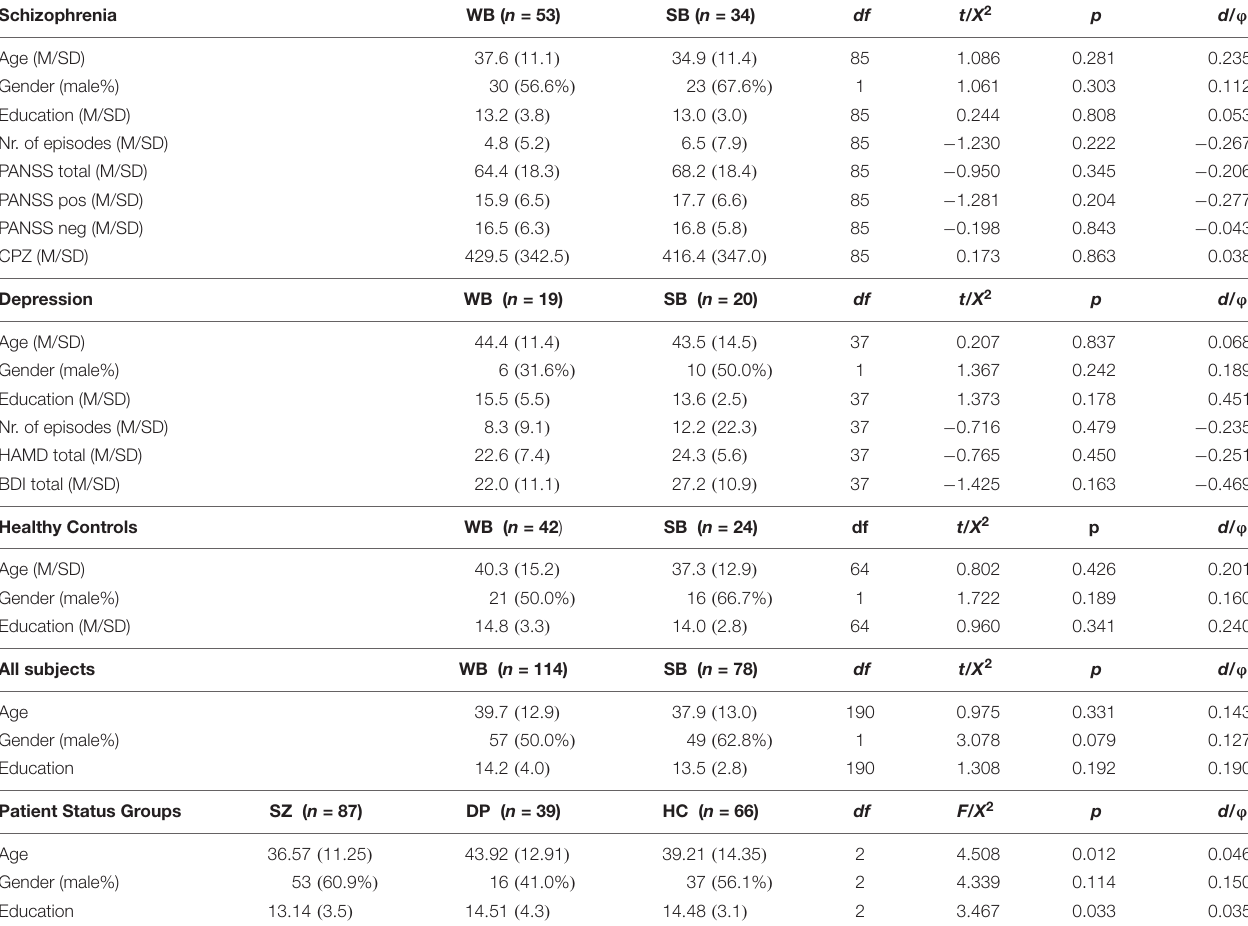
DP, when compared to winter-born DP. Furthermore, SZ patients had a decreased hippocampal volume compared to HC participants and DP patients, independent of season of